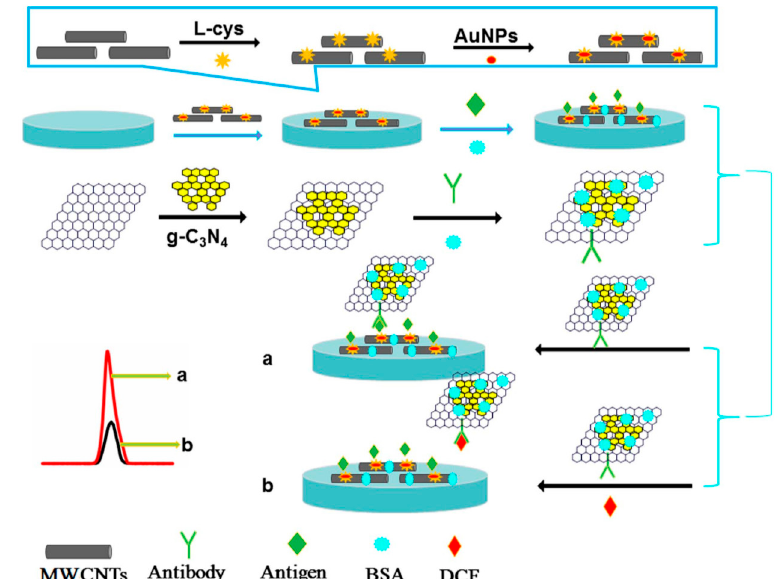
Figure 3. Procedure assembly scheme of a electrochemiluminescent immunosensor for diclofenac detection consisting on a GCE / MWCNTs-AuNPs / coating antigen / BSA / GO-g-C 3 N 4 labeled DCF antibody (reproduced from [116], with permission from Elsevier, 2017).